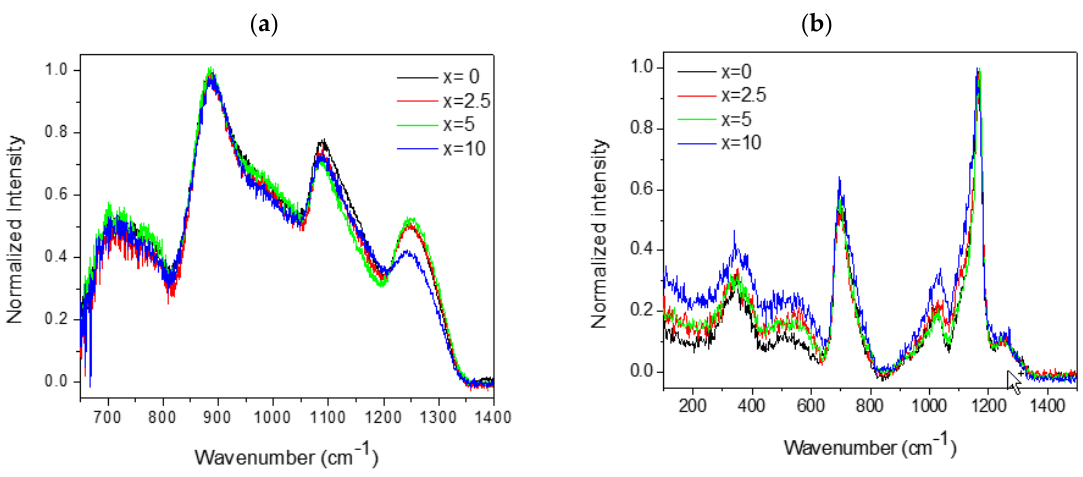
Figure 1. IR ( a ) and Raman ( b ) spectra of the investigated glasses.